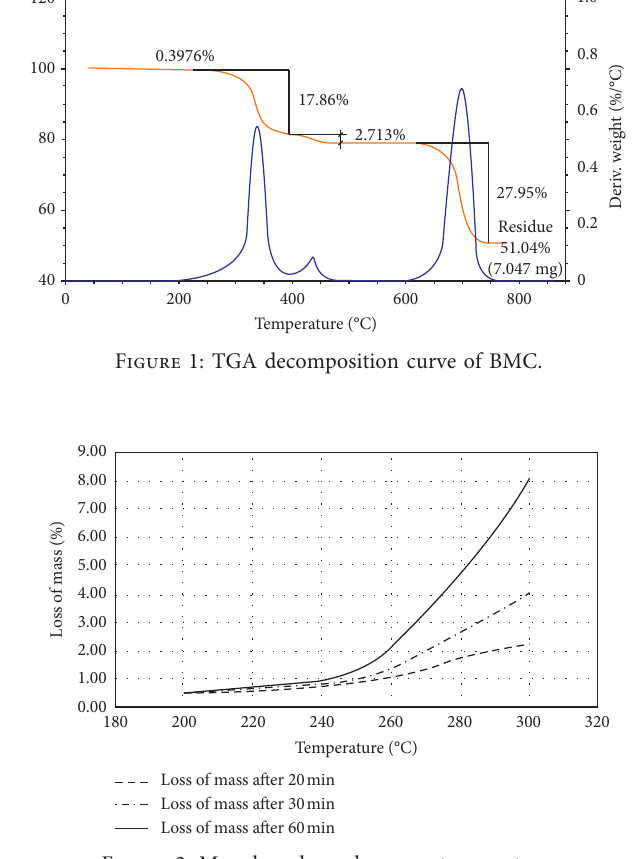
Figure 2: Mass loss dependence on